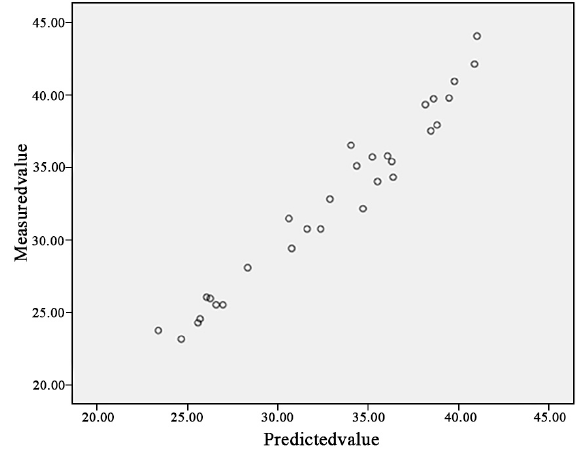
Fig. 12. Relationship between measurements and